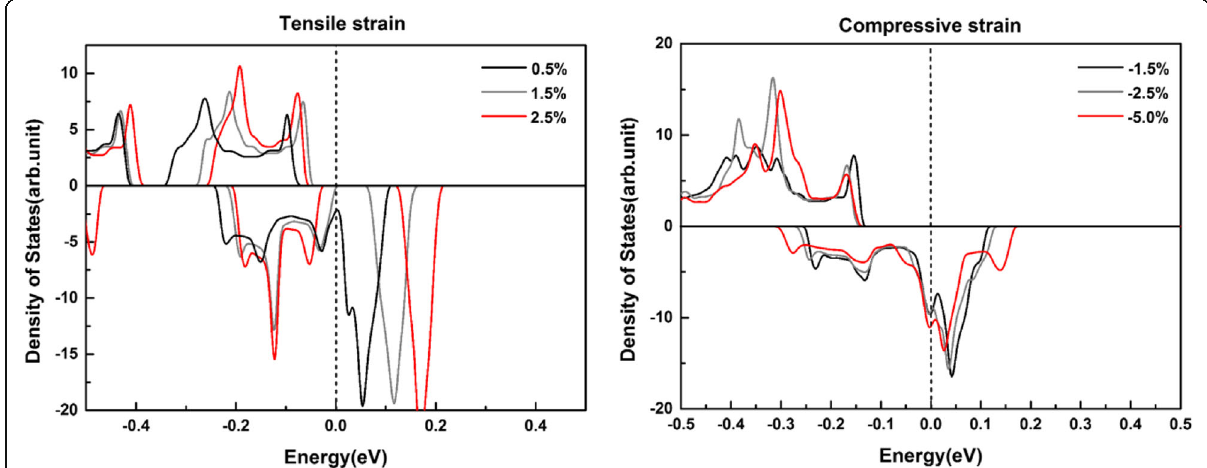
Fig. 5 The spin-dependent total density of states of B C1 @gh-C 3 N 4 (with 8.33% doping concentration) under in-plain biaxial tensile strain (left) and biaxial compressive strain (right), respectively. The energy at the Fermi level is set to